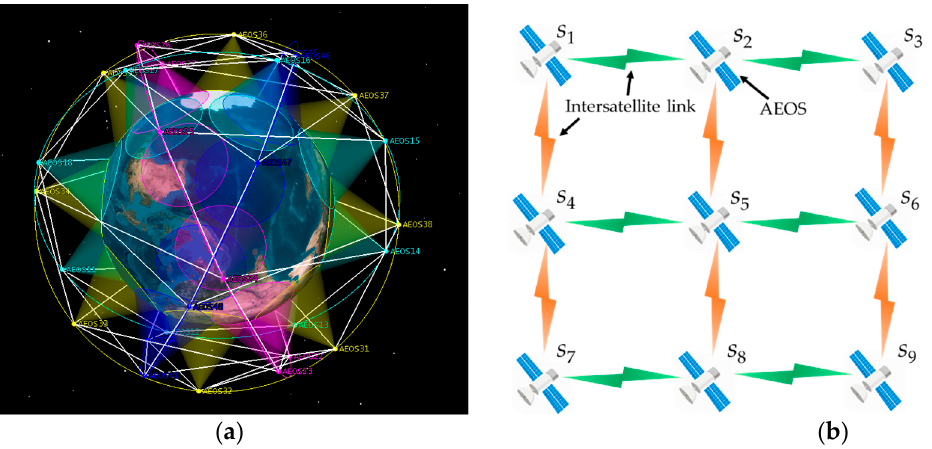
Figure 2. ( a ) An AEOS constellation with 36 AEOSs; ( b ) ISLs connections where s 5 connects the closest AEOSs s 2 and s 8 are in the same plane but with s 4 and s 6 also being in adjacent orbital planes. A group of AEOSs in the constellation, denoted by S = { s 1 , s 2 , . . . , s m }, m ≤ N s , is